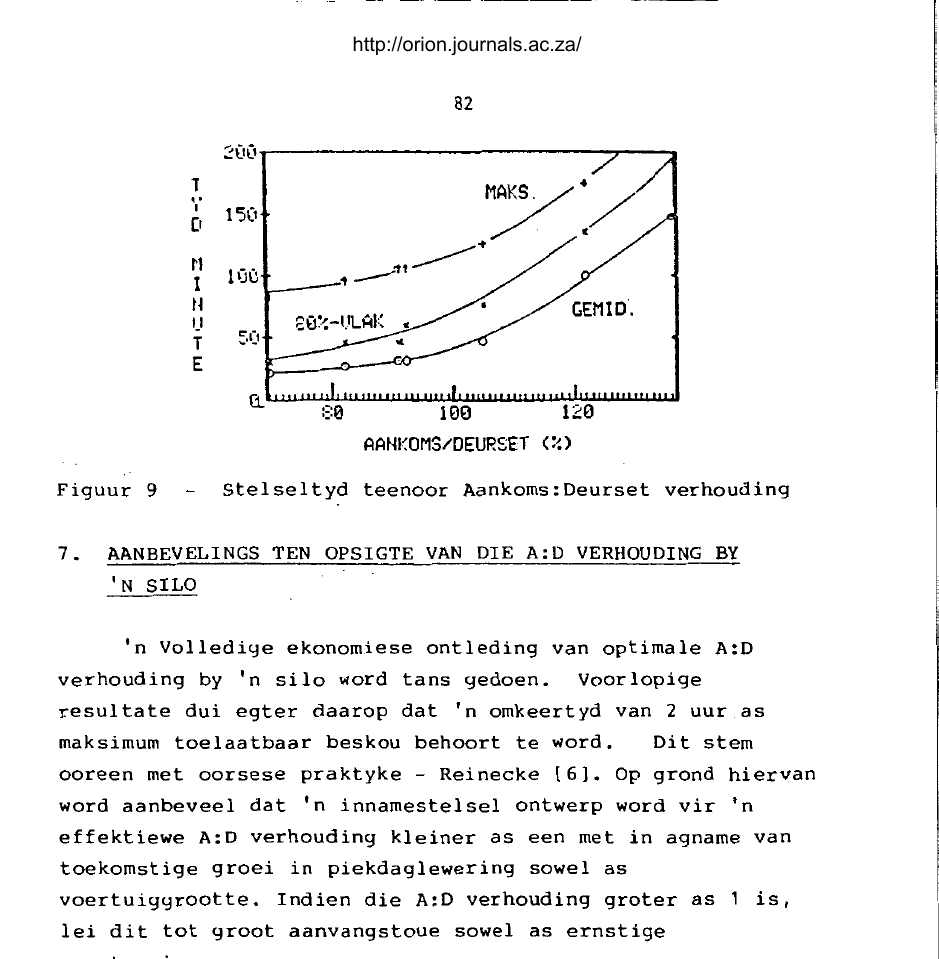
Figuur 9 Stelseltyd teenoor Aankoms:Deurset verhouding 7.